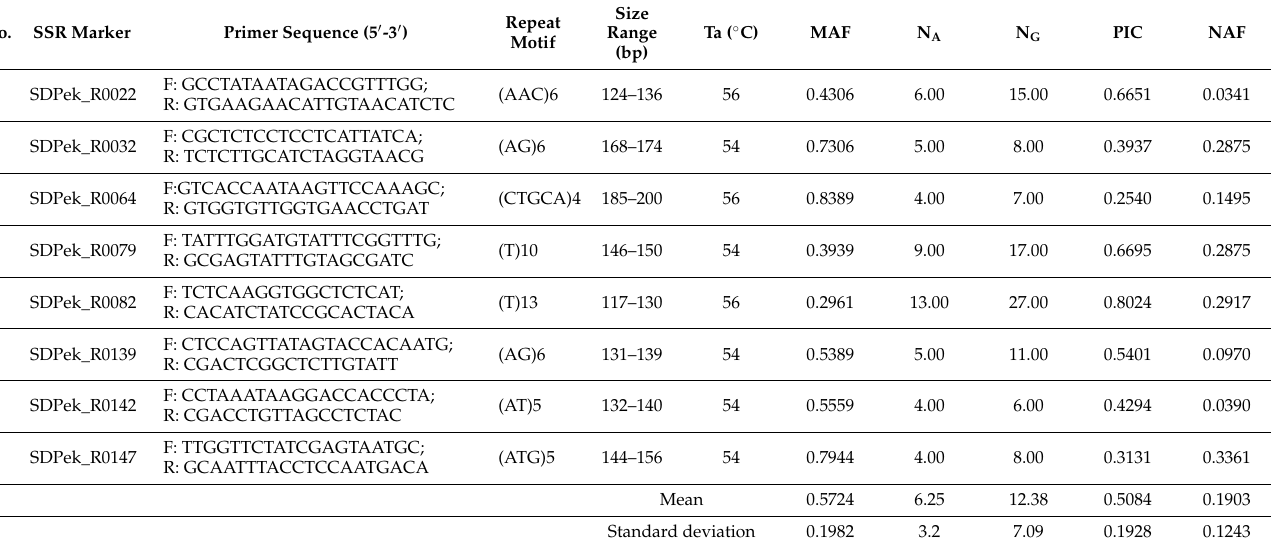
Table 2. Eight polymorphic SSR and their marker